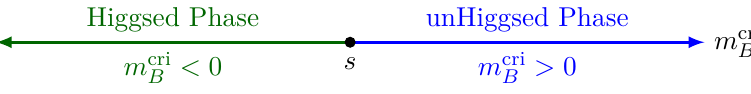
Figure 1 . Phase diagram of the critical boson theory as a function of m cri s marks the origin of the m cri